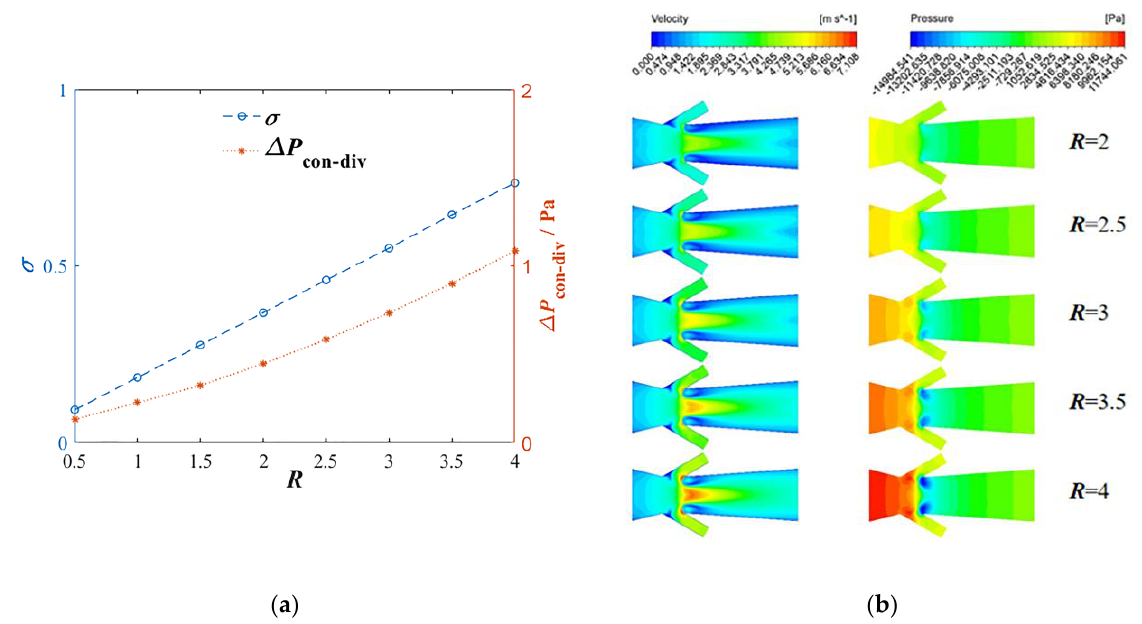
Figure 20. The effects of velocity ratio on ( a ) ∆ P con-div and σ, ( b ) velocity and pressure distributions in VTM.